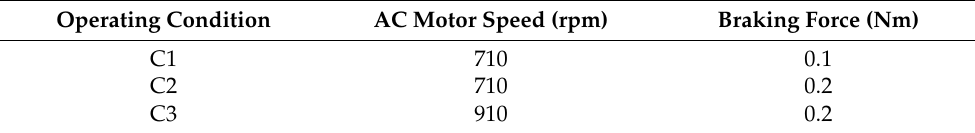
Table 3. Setting